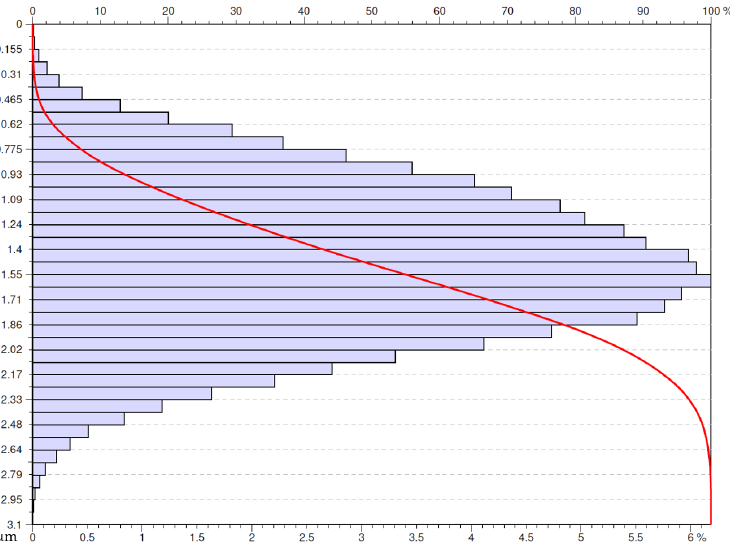
Figure 19. Abbott-Firestone curve after wet turning by Wiper insert with feed f = 0.05 mm/rev.